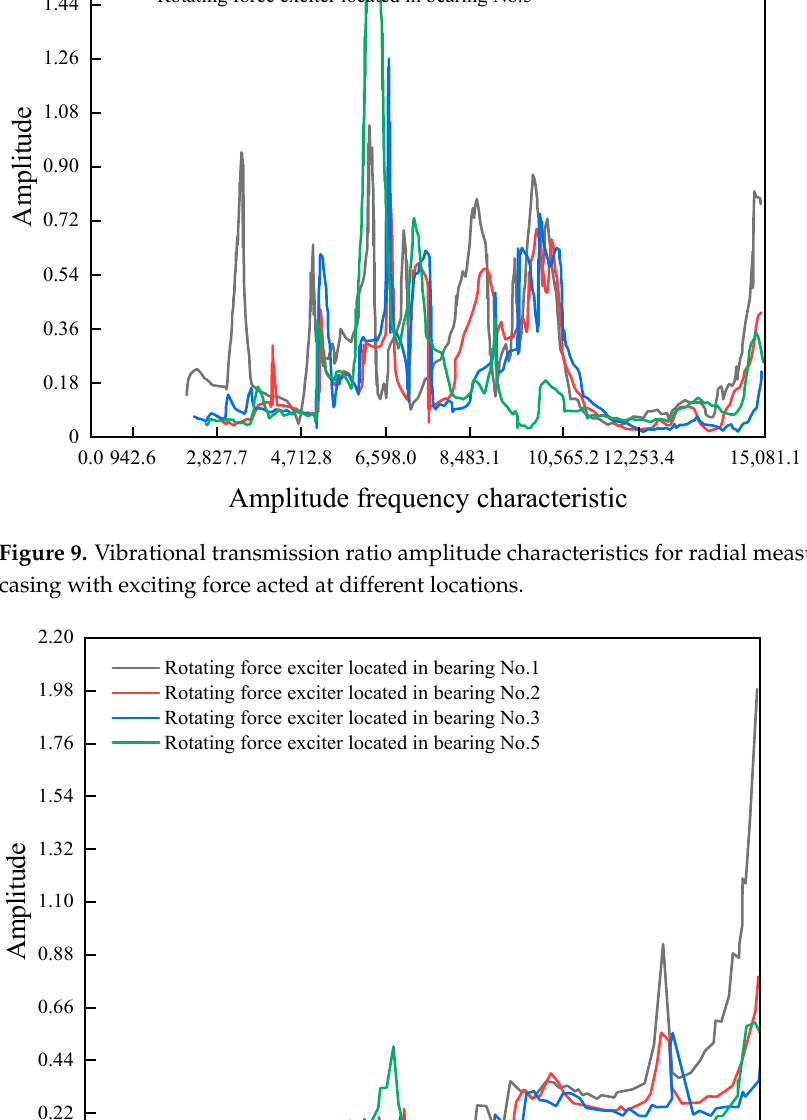
Figure 10. Vibrational transmission ratio amplitude characteristics for horizontal measuring point of the combustion chamber with exciting force acted at different locations.